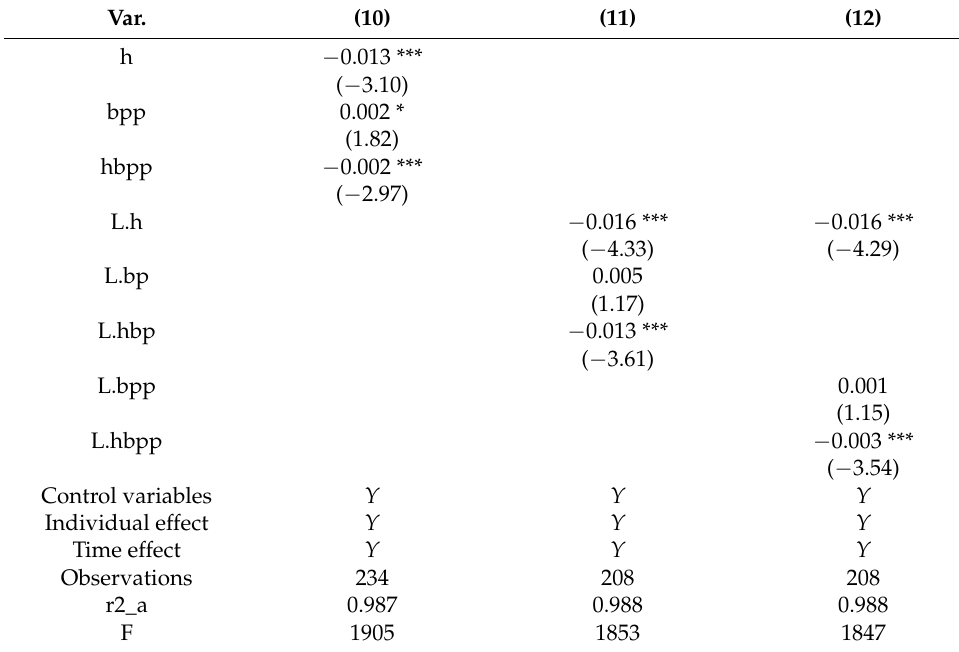
Table 3. The robustness test results of the baseline